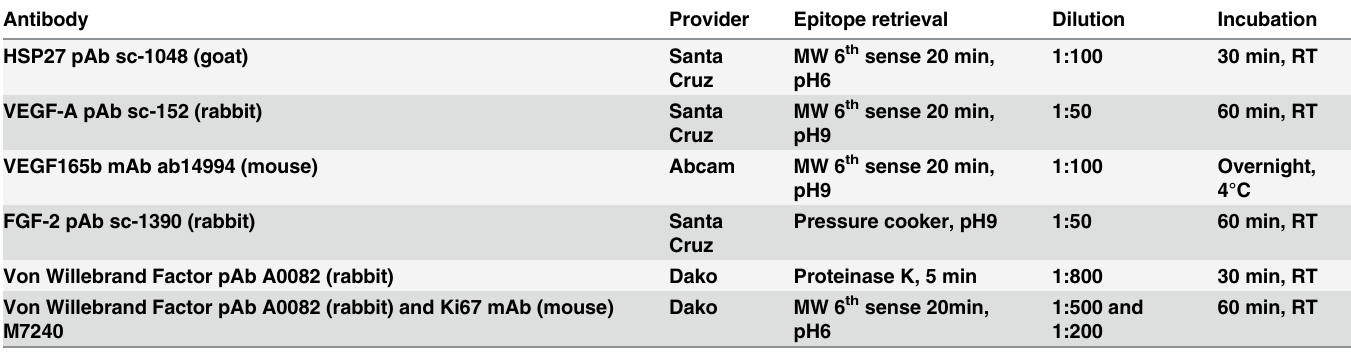
Table 1. Immunohistochemical staining